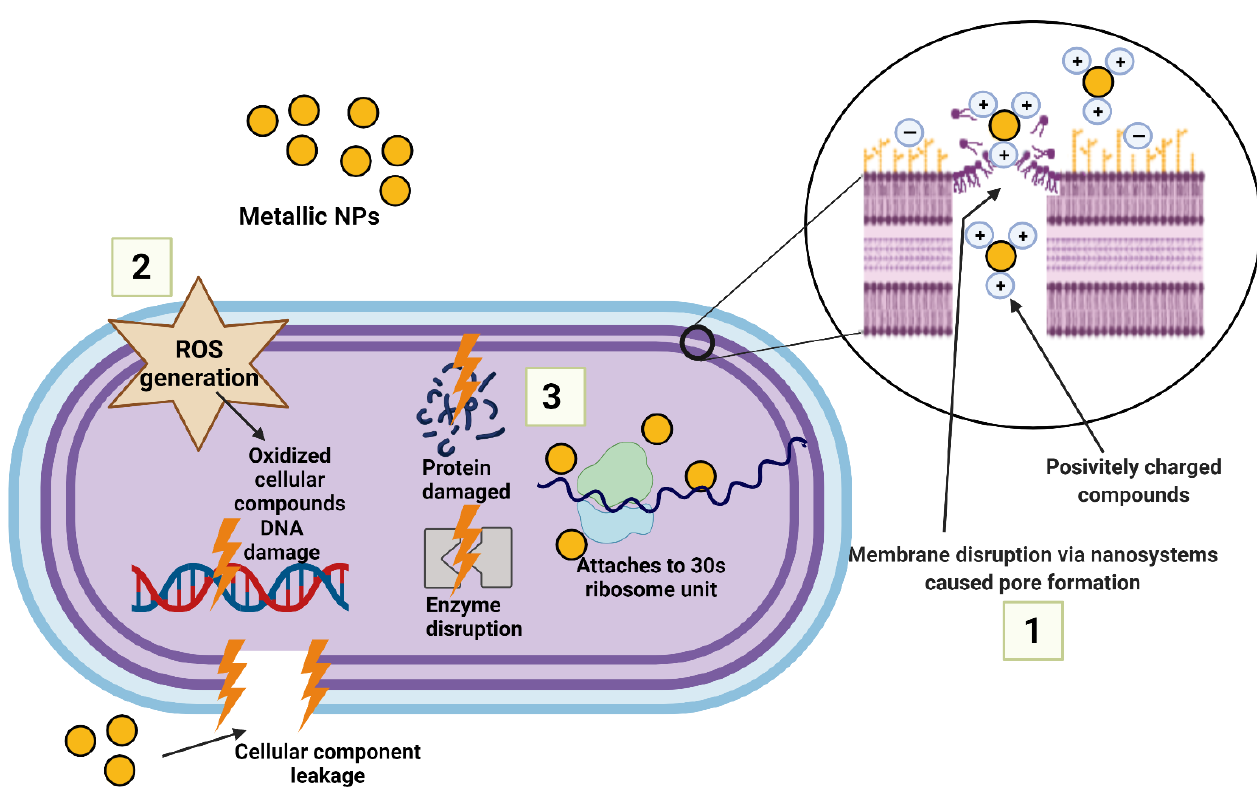
Figure 1. The main mechanisms of antimicrobial activity of metal nanoparticles include: (1) disruption of the pathogen cell wall resulting in increased permeability, (2) generation of ROS disrupting redox homeostasis and damaging cellular structures, (3) binding to intracellular structures causing their dysfunction.